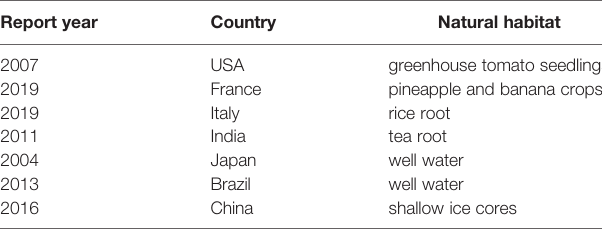
TABLE 4 | Cases of H. huttiense infections in natural habitat reported in the literatures.